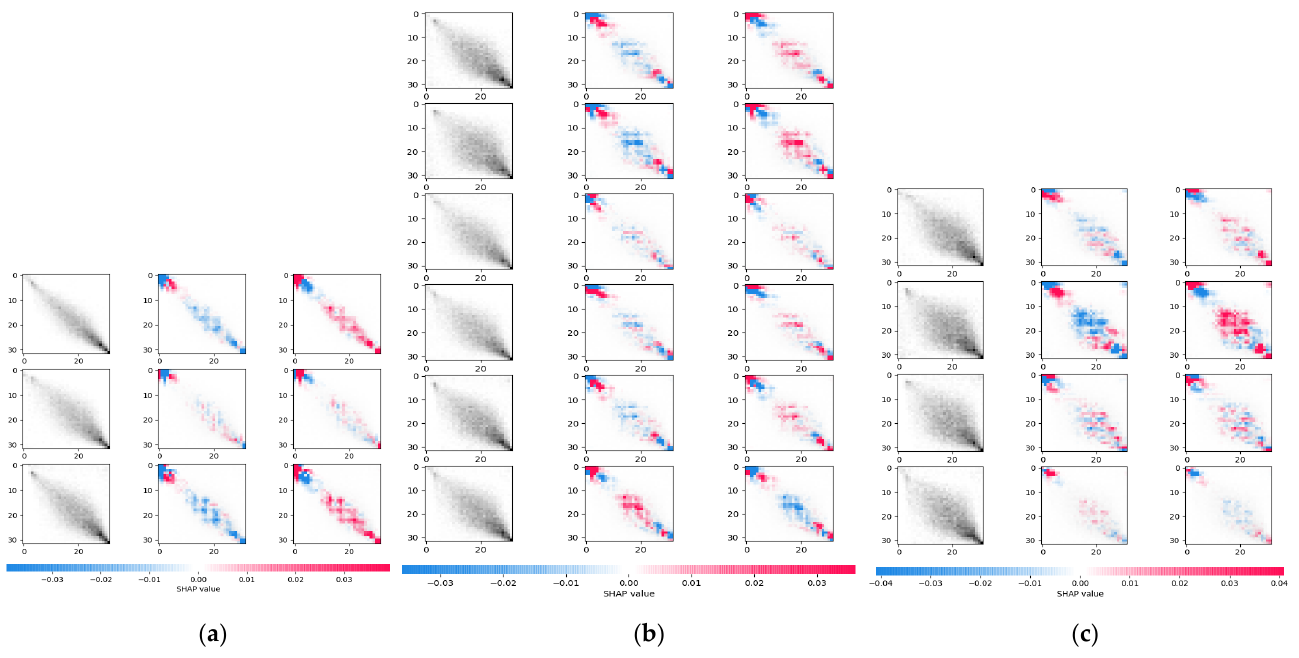
Figure 2. Visualization of information CNN learnt from each subgroups: ( a ) G 1 , ( b ) G 2 and ( c ) G 3 . The first column is the original GLCM. The corresponding label (0 for benign and 1 for malignant) and model score of the malignancy risk are listed on the top. The remaining two columns are the interpretations of model prediction on the two classes. The red cells show the entries push the model’s decision close to that class, while blue pixels pull the prediction results